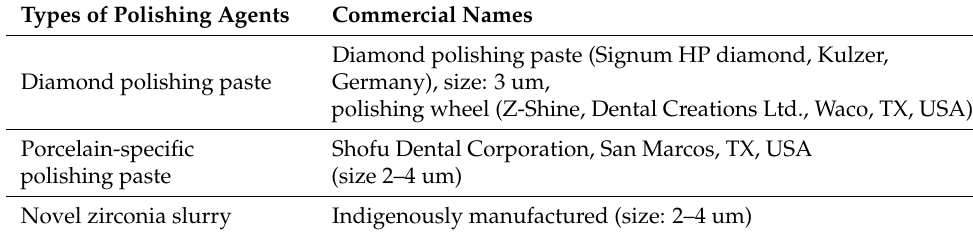
Table 2. Characteristics of polishing agents